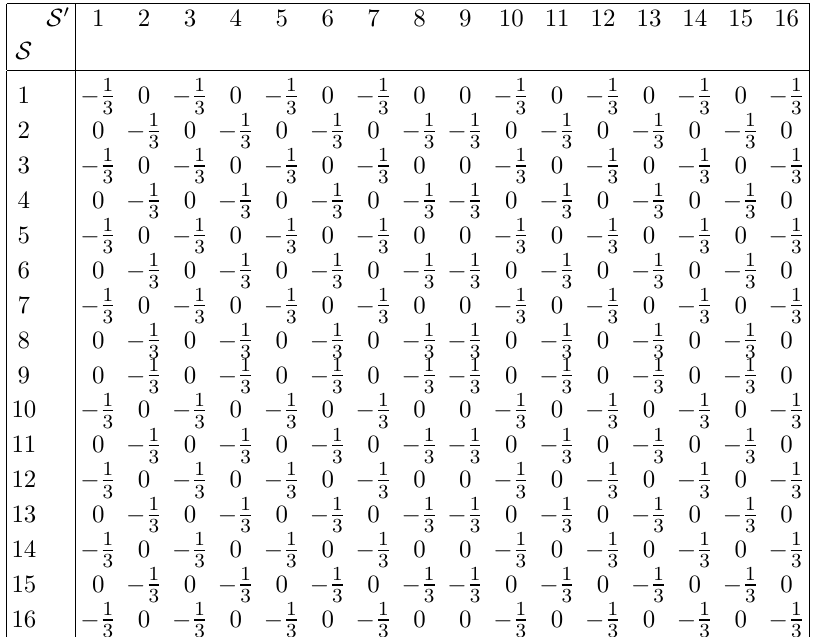
Table 31 . Gadget values for P